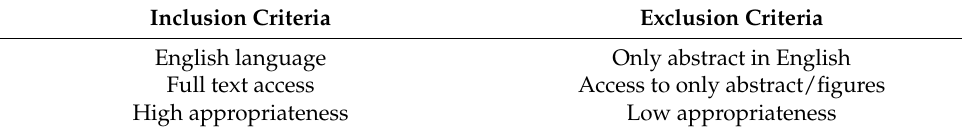
Table 2. Exclusion and inclusion